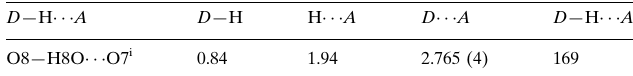
Hydrogen-bond geometry (A˚ , (cid:2)